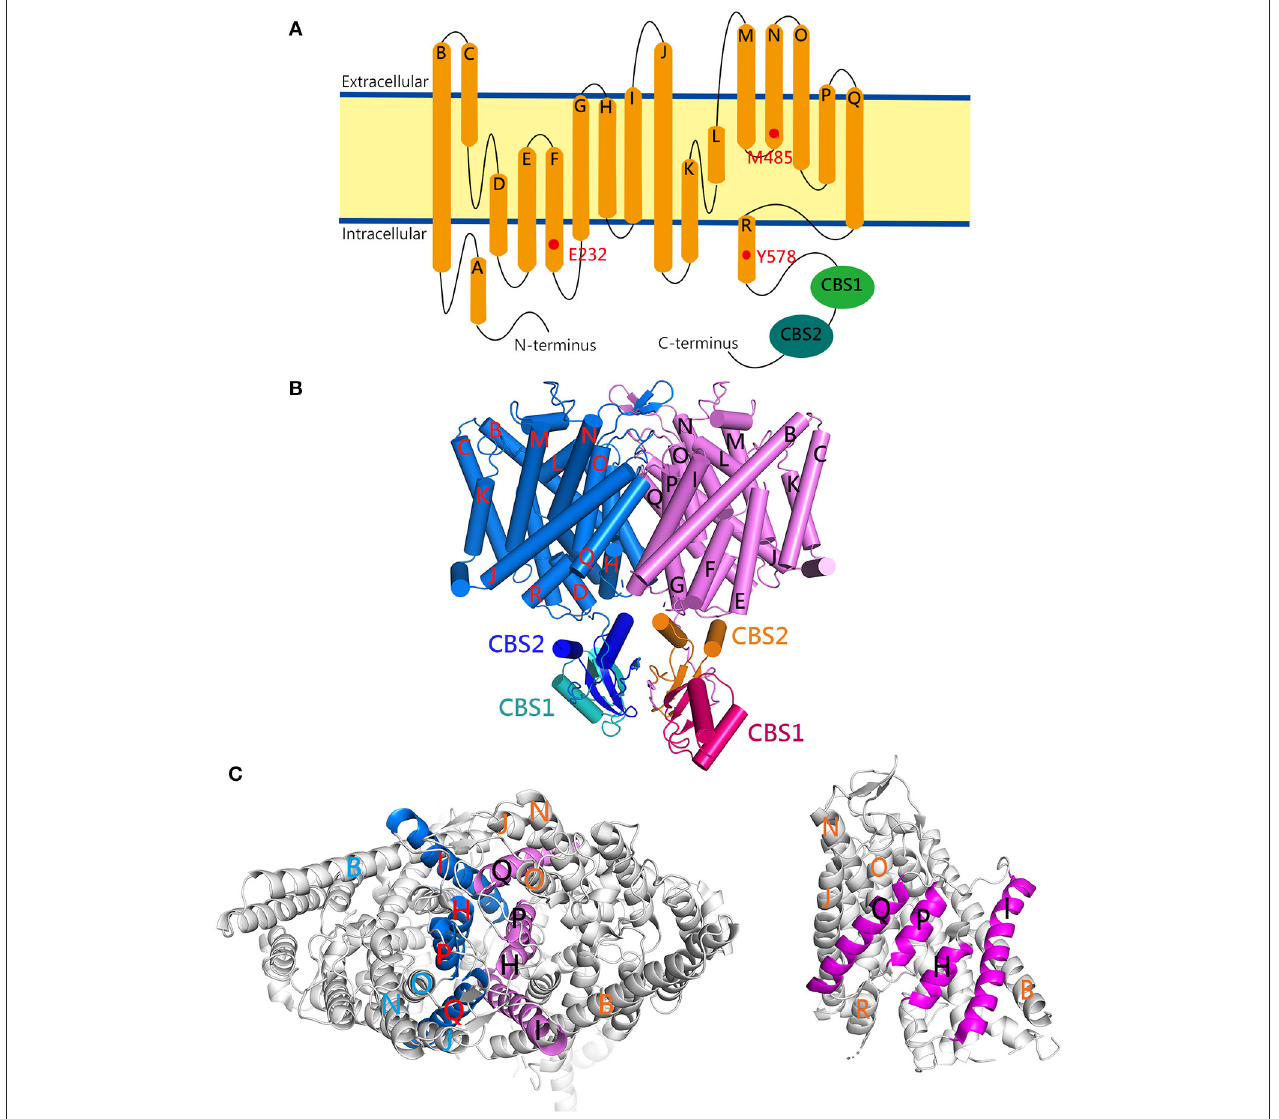
FIGURE 1 | The cryo-EM structure of the human ClC-1 channel. (A) Membrane topology of the ClC-1 subunit. The α -helices (A–R) are represented as cylinders. The locations of three pore-lining residues (E232, M485, Y578) and two cystathionine β -synthase (CBS) domains (CBS1, CBS2) are indicated. (B) Lateral view of the ClC-1 dimer (PDB code: 6QVC; presented using Pymol). The α -helices are shown as cylinders. The transmembrane portions of the two subunits in the dimer are colored in blue and magenta, respectively. Also highlighted are the CBS domains in the cytoplasmic carboxyl-terminal portion of each subunit. (C) The dimer interface of ClC-1. The interface-forming helices (H, I, P, Q) are drawn as colored ribbons. (Left) The ClC-1 dimer is viewed from the extracellular side. (Right) The ClC-1 subunit is viewed from the dimer interface of the opposing